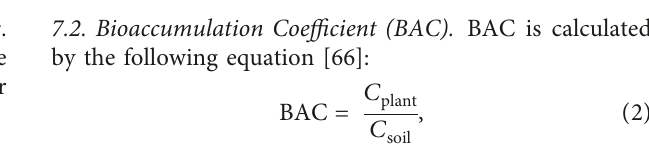
Figure 3: Schematic summarizing terms and concepts involved in trophodynamics of heavy metals ([62], used with permission of Tailor and